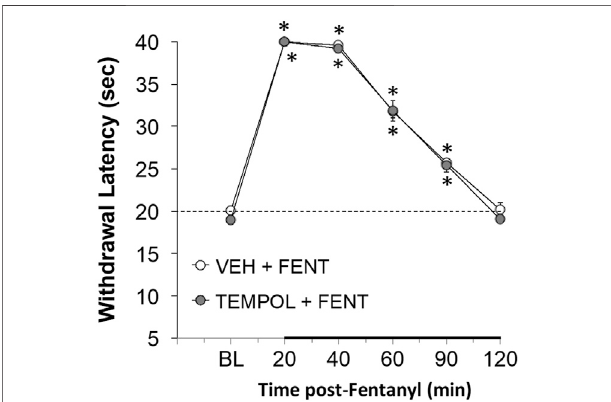
FIGURE 4 | The changes in paw-withdrawal latency from baseline (BL) elicitedby abolus injection offentanyl(25 μ g/kg, IV) inconsciousrats thathad received an injection of vehicle (VEH) or Tempol (100 mg/kg, IV) 20 min previously. There were six rats in each group. The data are presented as mean ± SEM. * p < 0.05, signi fi cant from baseline. There were no differences between Vehicle- or Tempol-treated rats at any time point ( p > 0.05, for all